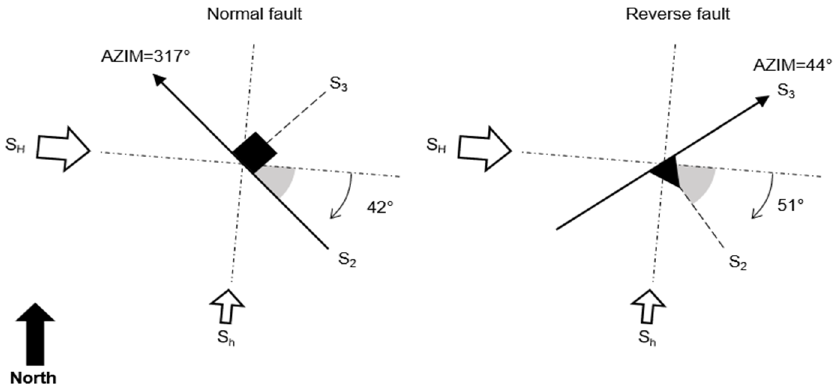
Figure 4. Applied stress field and transformation to 2D plane models. The transformation angle for the NF is 42° and for the RF is 51°.